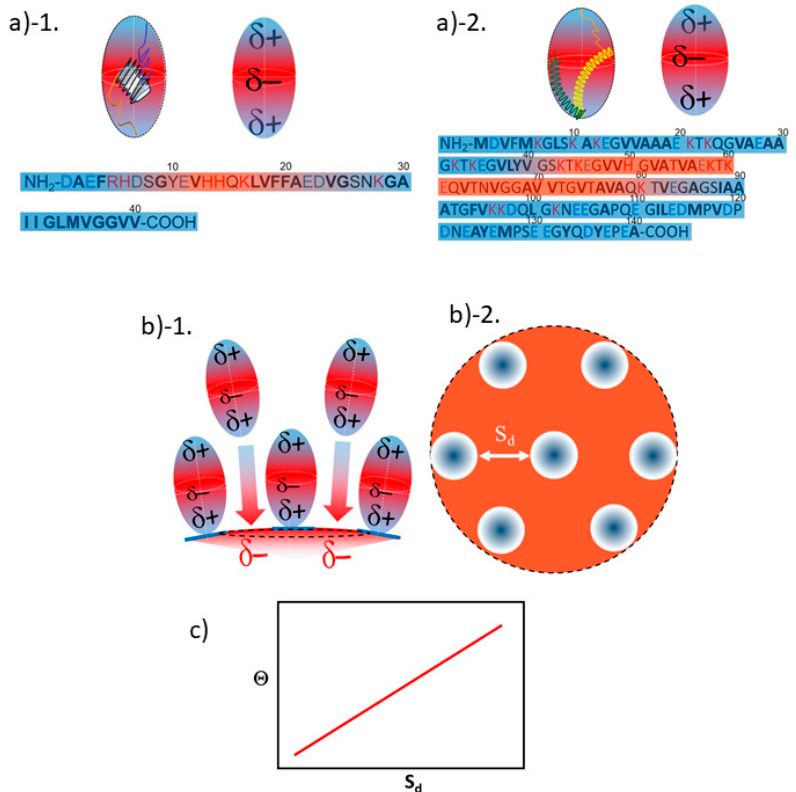
Figure 8. A sketch explaining a positive linear proportionality between Θ vs. S d , ( a ) simulation of prolate and charge distribution of A β 1–40 ( (a)-1 ) and of β 2m ( (a)-2 ). The sequences of each peptide are shown with the colored bar indicating δ – (in red) or δ + (in blue). ( (b)-1 ). A side view of a prolate top peptide with a partially positive side ( δ +) of dipole attaching to the partially negative surface ( δ –) of gold colloid. An extra prolate dipole attracted for the space of δ –, if S d has enough length to let an extra prolate in. ( (b)-2 ) The birds eye view of the surface showing area appears as δ – indicated by red is the highly probable are for an extra prolate to be interacted and may lead to an attachment. ( c ). A graph explaining the expected trend between Θ as a function of S d.